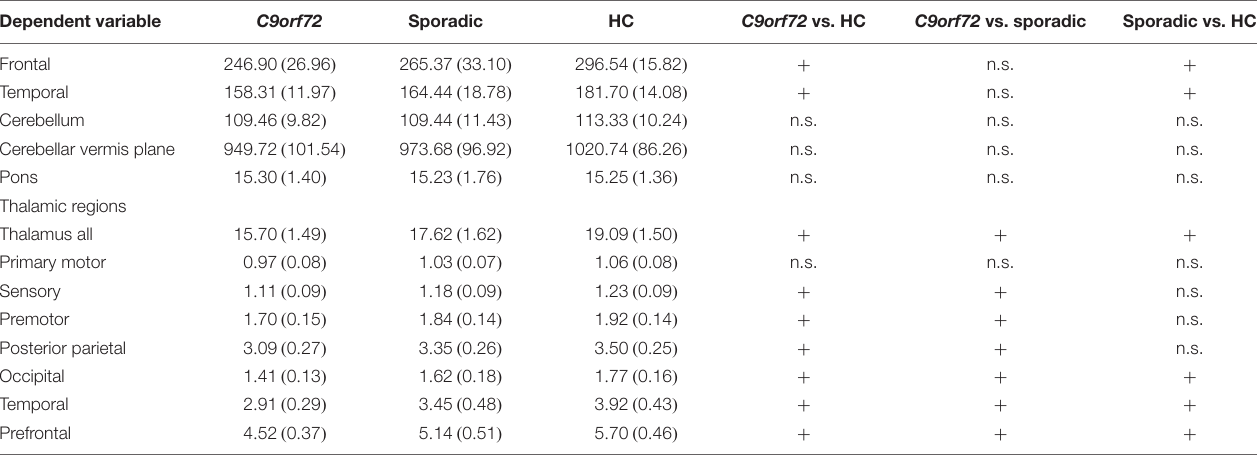
TABLE 2 | Anatomical structures selected for volumetric analysis per group mean and SD (in ml), and pairwise post hoc Bonferroni test results. Dependent